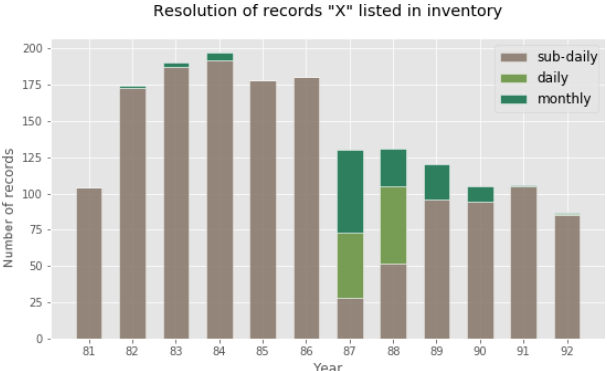
Figure 4. Bar chart showing the resolution for each data series marked by an “X” in the inventory. The different formatting of the years 1787 and 1788 meant many records were printed as daily means and monthly summaries instead of the usual sub-daily